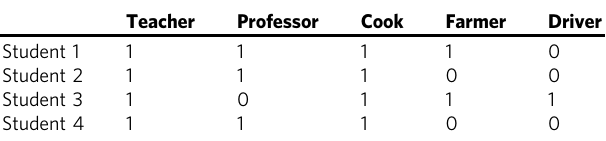
Table 1 Example of student-word matrix.